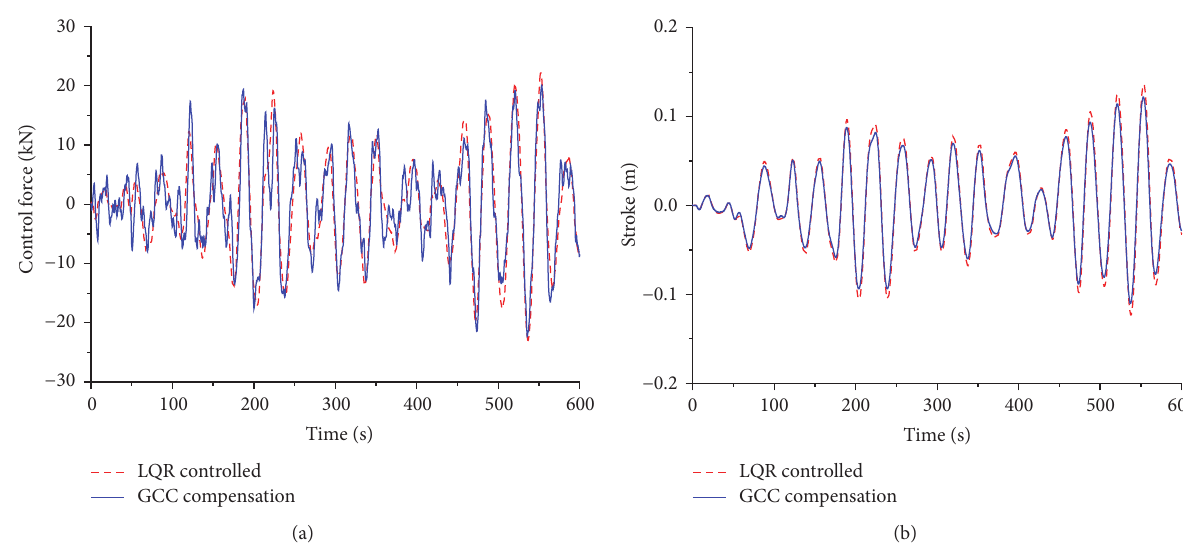
Figure 6: Comparison of AMD parameters, (a) AMD control forces, and (b) AMD strokes.